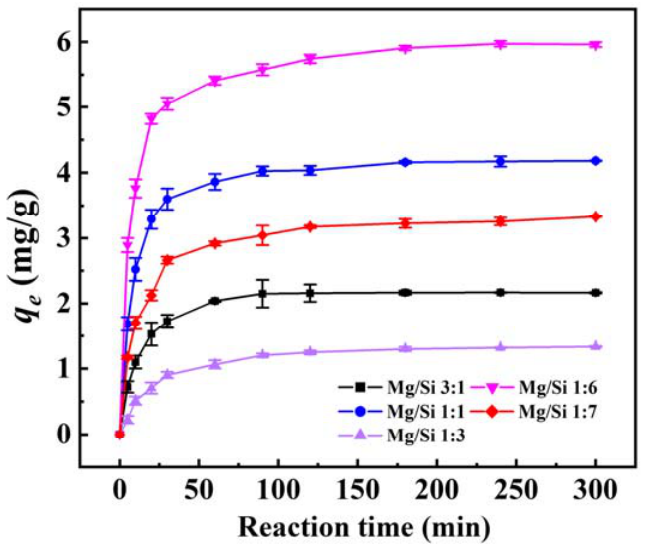
Figure 2. Influence of Mg/Si ratio on adsorption capacities of magnesium silicate for 4 − NP.